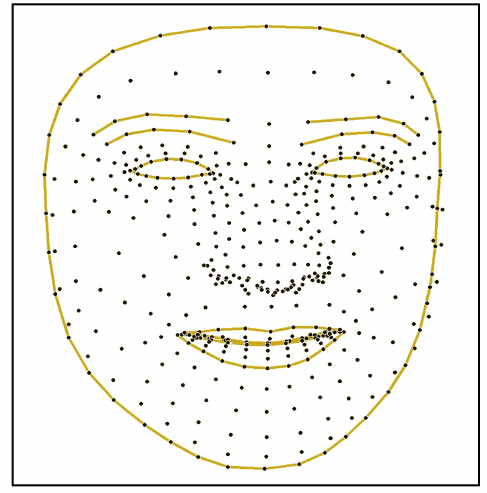
Figure 4. Face landmarks